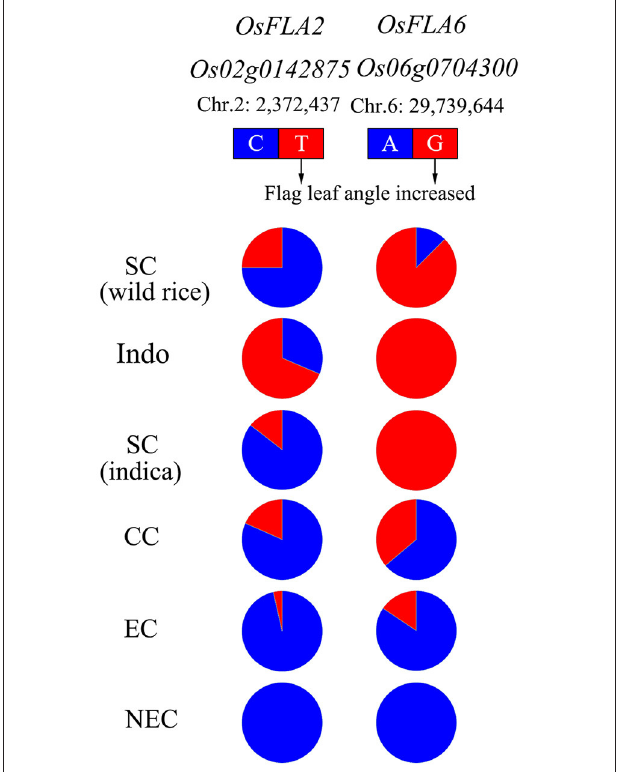
FIGURE 6 | The gene allele frequency differences at the causal polymorphisms of OsFLA2 and OsFLA6 in five geographic groups. The type of reference allele is indicated in blue, and the alternative is indicated in red. Indo, Indonesia; SC, southern China; CC, central China; EC, eastern China; NEC, northeastern China. The accessions from SC were mainly wild rice and indica subspecies. The accessions from Indo were mainly tropical japonica subspecies. The accessions from CC were mainly indica subspecies. The accessions from EC and NEC were mainly temperate japonica